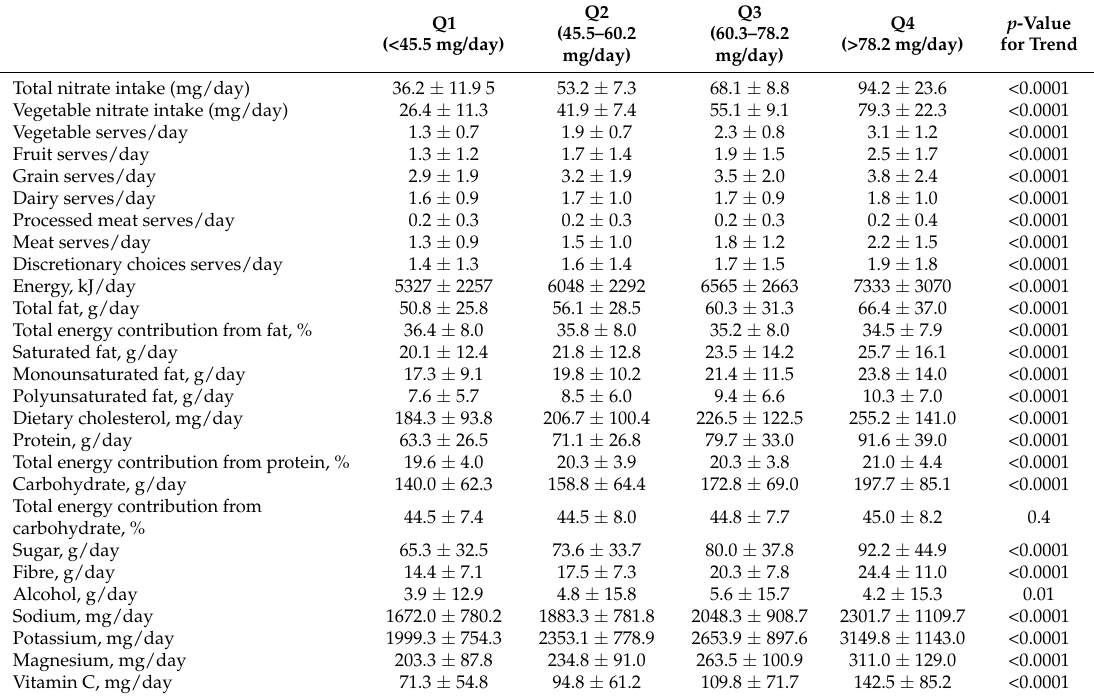
Table 2. Summary of dietary intakes for all study participants by quartile for total dietary nitrate